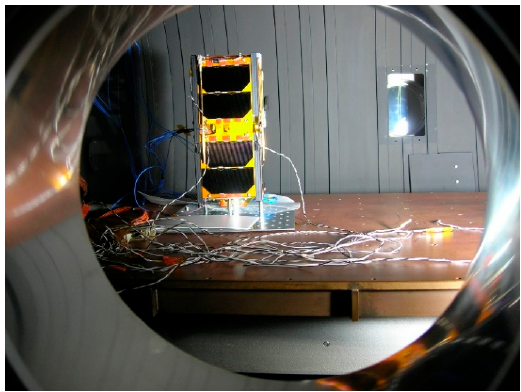
Figure 15. SE01 in the thermal-cycling chamber.